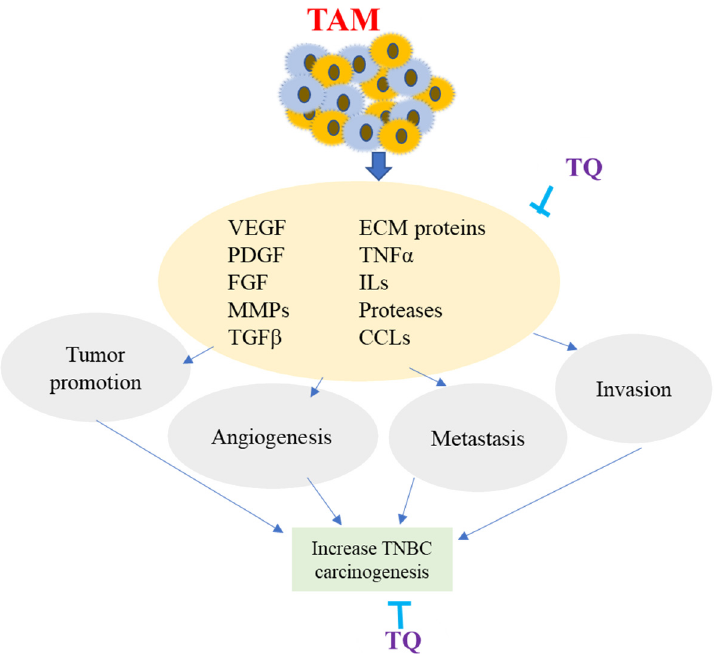
Figure 5. Overview of Tumor-Associated Macrophage (TAM). TAM is produced from monocytes recruited at the tumor site by molecules produced by TME. Major factors involved in TAM are the chemokines (CCLs), vascular endothelial growth factor (VEGF), interleukins (ILs), transforming growth factor (TGFa), matrix metalloproteinases (MMPs), extracellular matrix proteins (ECM), and platelet-derived growth factors (PDGF). TAM produces several molecules that sustain malignant cell survival, modify neoplastic ECM proteins, enhance invasion and metastasis, promote the de- velopment of a newly formed vessel, and assist tumor cells in their progression. TQ potentially inhibits TAM-related expression of various factors and proteins, resulting in decreasing angiogenesis, invasion, and metastasis of TNBC.